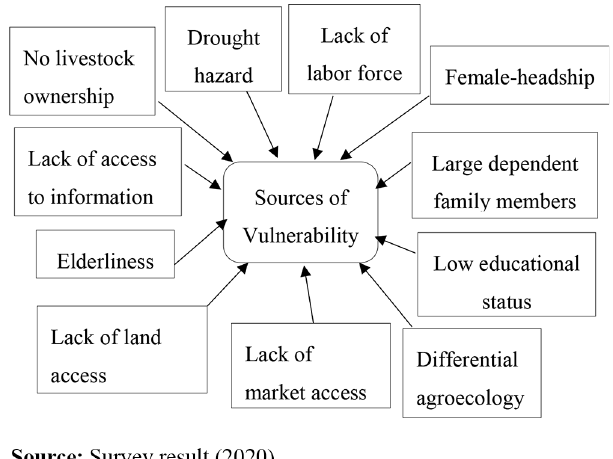
Figure 3. Sources of community vulnerability in the Gamo